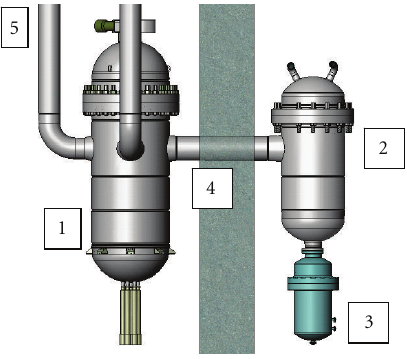
Figure 2: : ETDR plant overview